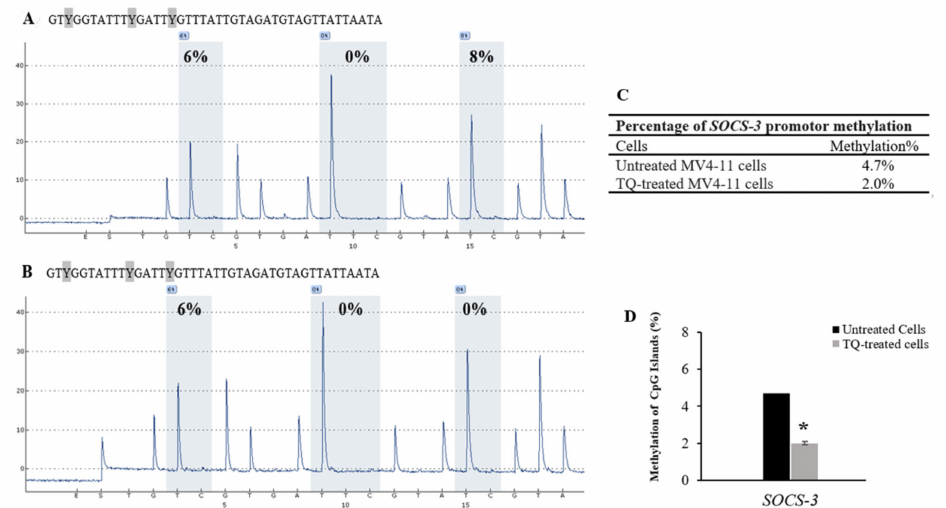
Figure 6. Effect of TQ on the methylation of SOCS-3 promoter region in MV4-11 cells. ( A ) Pyrose- quencing pyrograms for the methylation status of SOCS-3 promoter region in untreated MV4-11 cells and ( B ) TQ-treated MV4-11 cells. The percentages shown above each “C” base are the methylation level of the CpG site. ( C ) Percentages of SHP-1 methylation in MV4-11 cells. ( D ) The bar graph shows hypomethylation of SOCS-3 in MV4-11 cells after TQ treatment. Repeated measure ANOVA was applied, and the values are stated as mean ± SD; where * p < 0.05 is significant versus untreated control